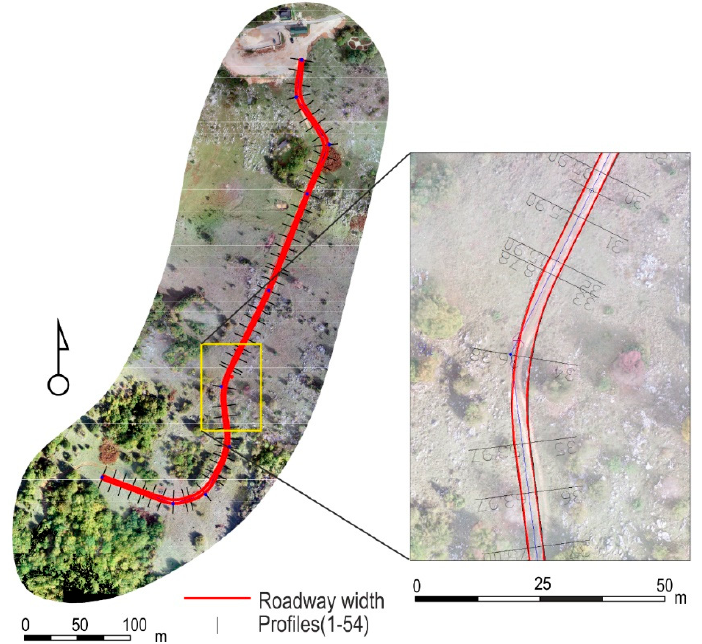
Figure 6. Designed forest/skid road in the zone of the research area on 3D terrain from GNSS elevation points within pavement that is 3.00 m in width.